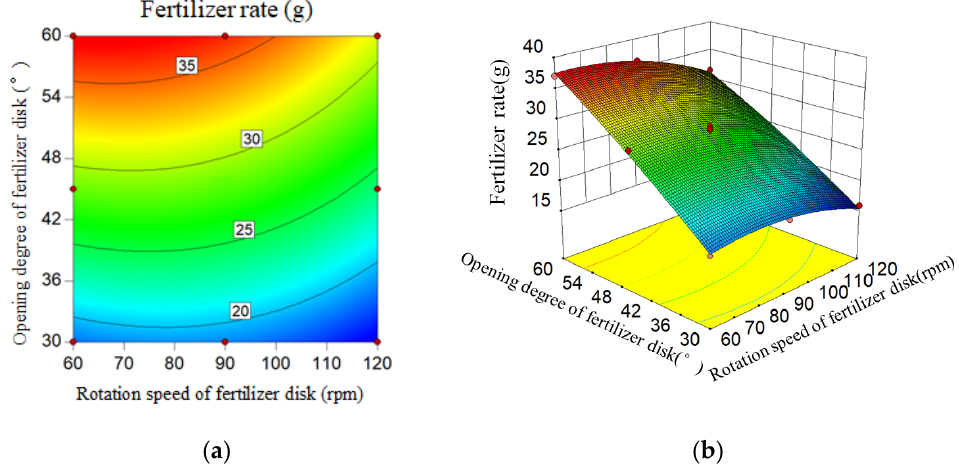
Figure 10. Relationship between fertilizer application rate and the rotation speed and opening of fertilizer disk. ( a ) Contour map; ( b ) Response surface.